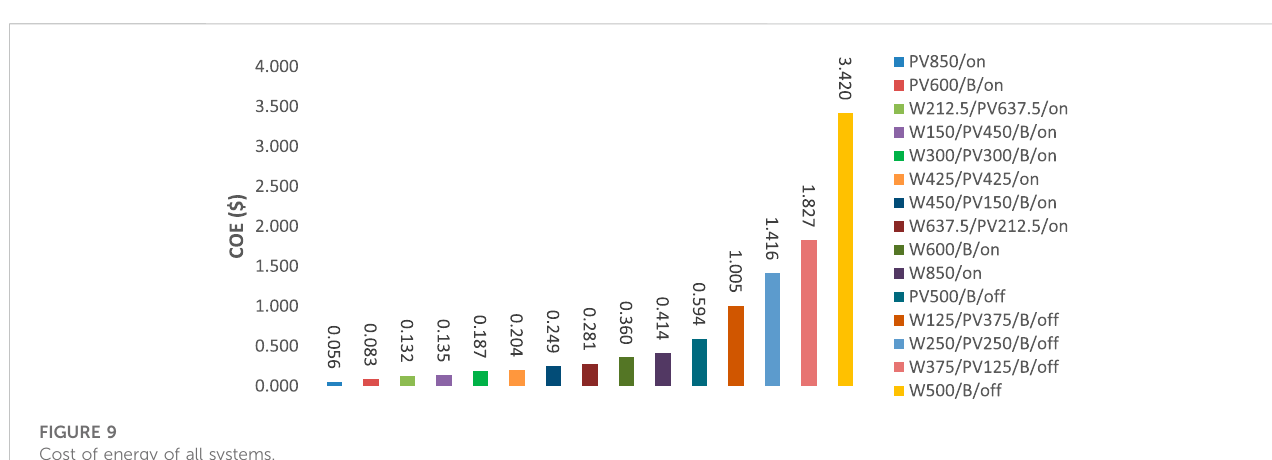
FIGURE 8 Net present cost of all systems.